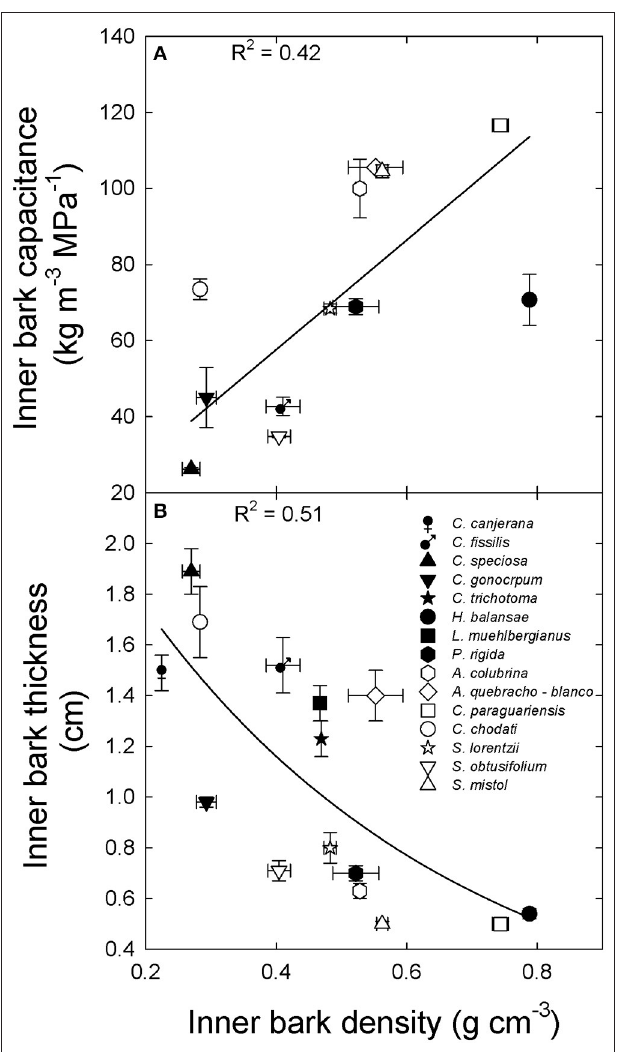
FIGURE 2 | Relationship between (A) inner bark capacitance and (B) inner bark thickness and inner bark density for tree species from the extremes of a precipitation gradient in northern Argentina. Black symbols correspond to wet extreme and white symbols to dry extreme. Lines are the functions fixed to the data [ (A) y = 144x, p < 0.001; (B) y = 2.6 exp − 2x ; p < 0.001].